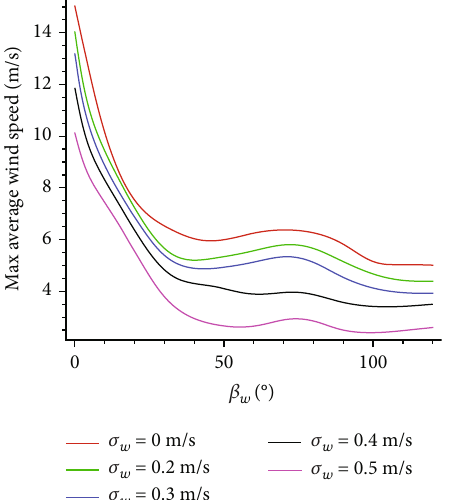
Figure 29: The maximum average continuous wind speed with di ff erent fl uctuation intensities that the Quad-Plane can reject at di ff erent sideslip